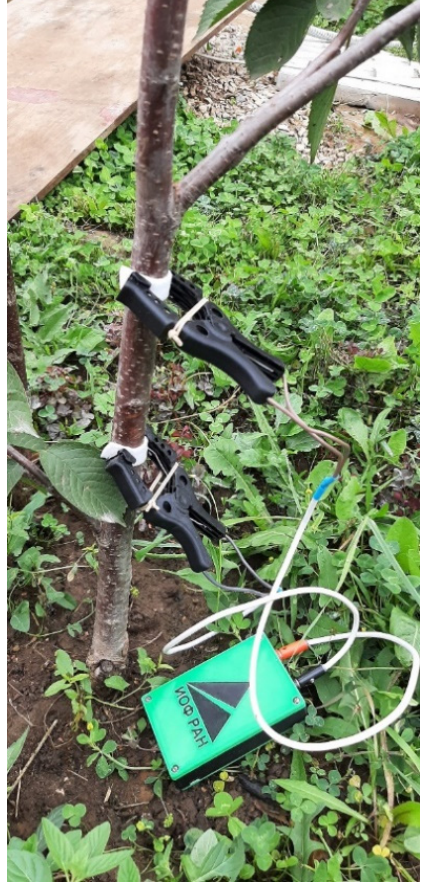
Figure 3. Measuring the electrical impedance of the grafting zone 6 months after grafting: 1, 2— electrodes located at a distance of 100 ± 5 mm from each